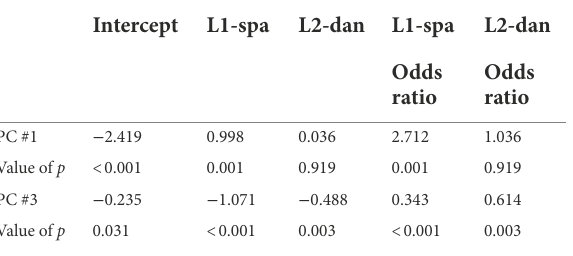
TABLE 5a Multinomial logistic regressions with PC #2 as baseline (L1-Danish baseline).